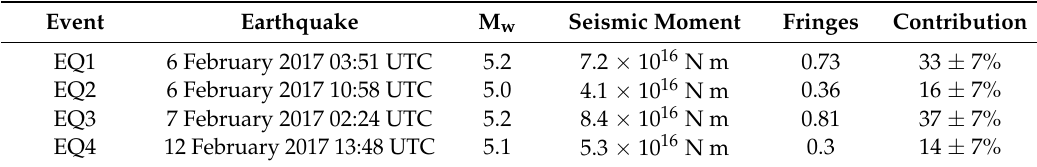
Table 5. Estimated contribution of the four main events to the total ground deformation. M w and seismic moment are from NOA (Table